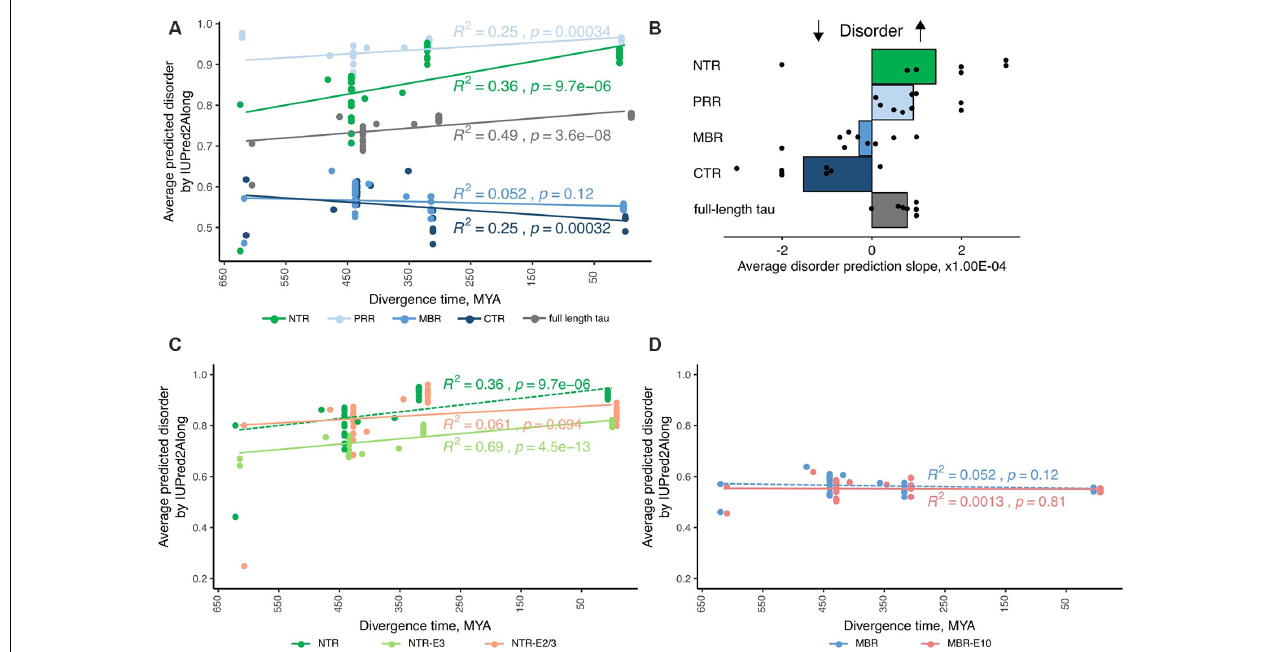
FIGURE 2 | Tau’s amino-terminal, non-microtubule binding region exhibits a strong evolutionary increase in disorder. (A) An exemplary plot of disorder prediction by IUPred2A long is shown. Species are grouped by divergence times between their higher taxons and mammals [cyclostomes or jawless fishes—615 million years ago (MYA), cartilaginous fishes—473 MYA, bony fishes—435 MYA, coelacanths—413 MYA, amphibians—352 MYA, reptiles and birds—312 MYA and mammals as a 0 value]. R squared and p -value characterizing the linear fit to the data are presented close to each respective fitting line. (B) Average values of slopes based on linear regression analysis of predicted disorder values from all selected algorithms for full-length tau and all selected regions (NTR—green, PRR—light blue, MBR—blue and CTR—dark blue) are shown. Black dots represent values for measured slopes for the individual prediction algorithms while bars show average values. Note, that NTR and PRR show an increase in disorder, while the CTR shows a decrease. (C,D) Plots of disorder prediction by IUPred2A for NTR lacking exon 2/3 or exon 3 (C) and MBR lacking exon 10 (D) are shown. Full-length NTR and MBR as also presented in (A) are indicated by dashed lines. Species are grouped as described before. R squared and p -value characterizing the linear fit to the data are presented close to each respective fitting line.